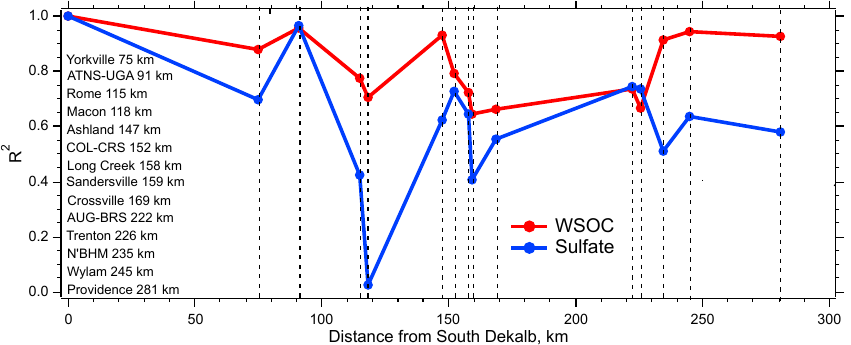
Fig. 5. Site-to-site correlations of WSOC and sulfate between South Dekalb (a site within urban Atlanta) and other 14 sites in the southeast. Distance between South Dekalb and the other site is given in ascending order.